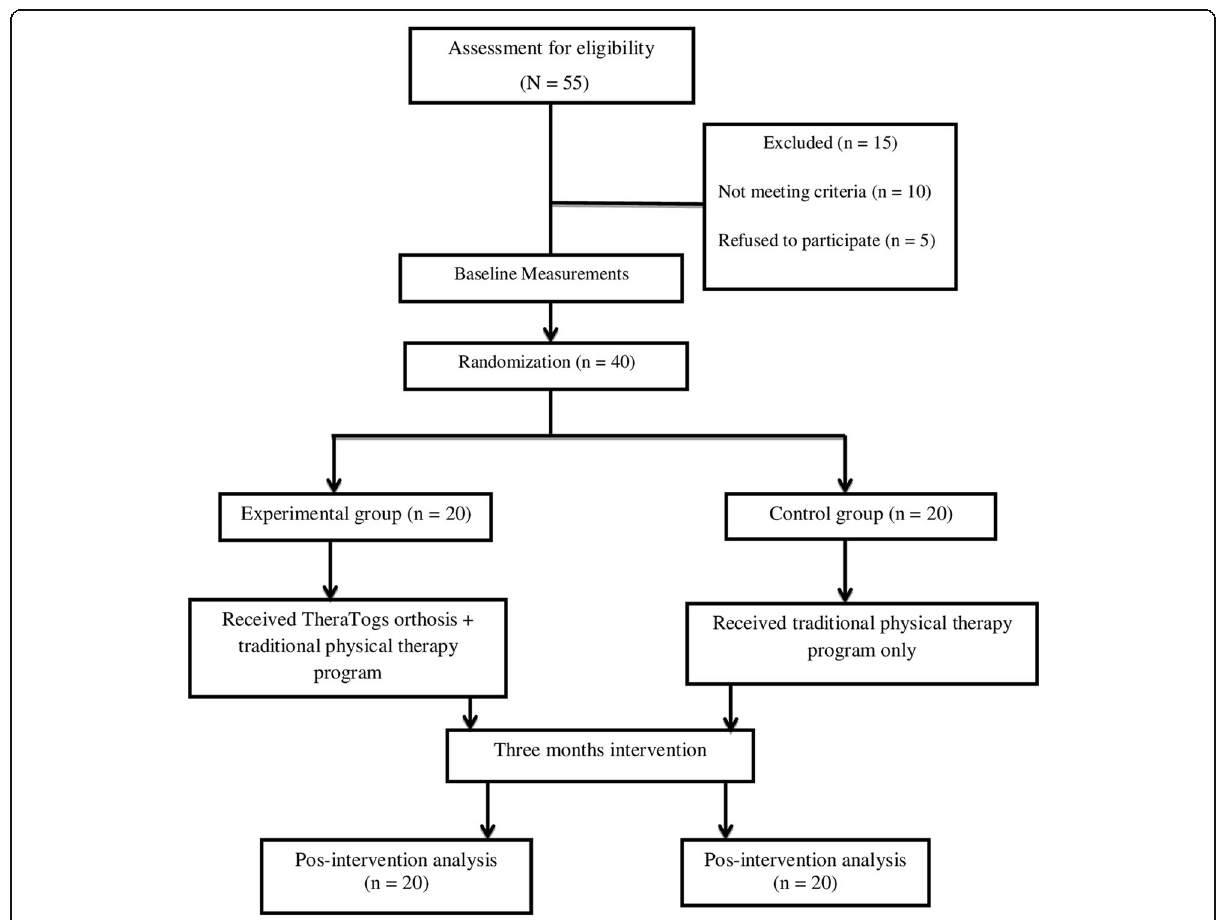
Fig. 1 Flow chart showing the experimental design of the